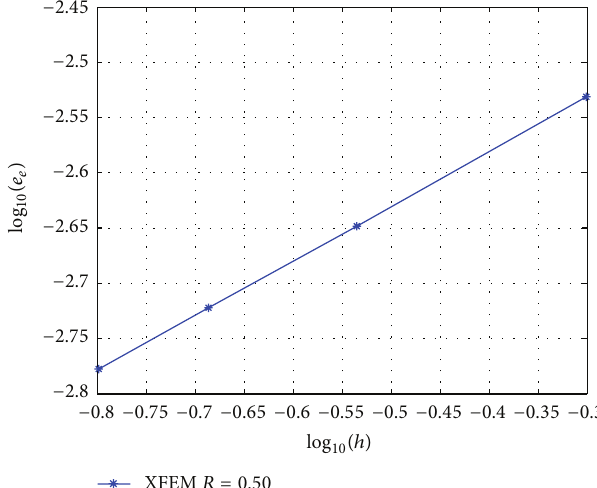
Figure 17: Strain energy for a sheet with an edge crack under shear. with 𝑉 = { u | u ∈ 𝐻 1 (Ω \ Γ 𝑐 ) , u = u on Γ 𝑢 , u discontinuous on Γ 𝑐 } and 𝑉 0 = {𝛿 u | 𝛿 u ∈ 𝐻 1 (Ω \ Γ 𝑐 ) , 𝛿 u = 0 on Γ 𝑢 , 𝛿 u discontinuous on Γ 𝑐 } .